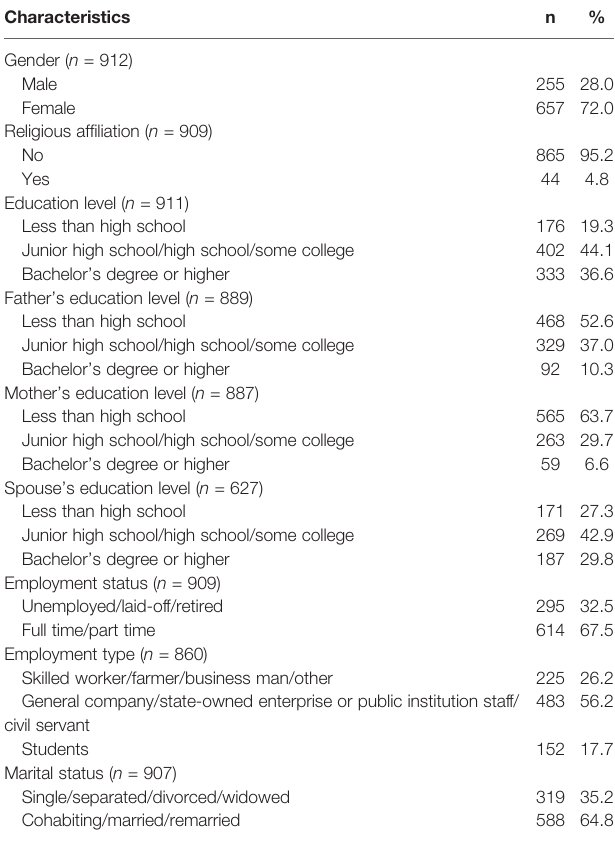
TABLE 1 | Socio-demographic characteristics of the study sample (N =